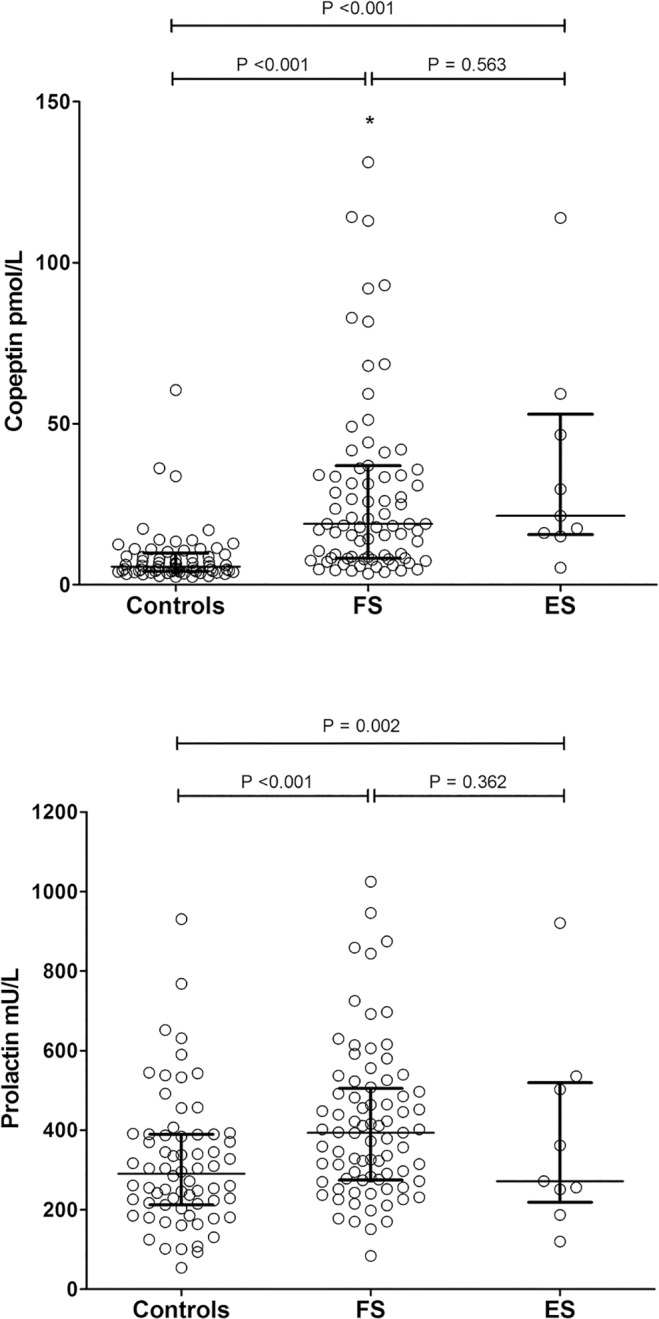
Scatter dot plots of serum copeptin and prolactin values in the three study groups.Medians and interquartile ranges are also presented. Between-group comparisons were performed with Mann-Whitney U test. * Serum copeptin values in 4 cases (range 208–306 pmol/L) are outside the copeptin-axis limits of the graph. FS: febrile seizures; ES: epileptic seizures